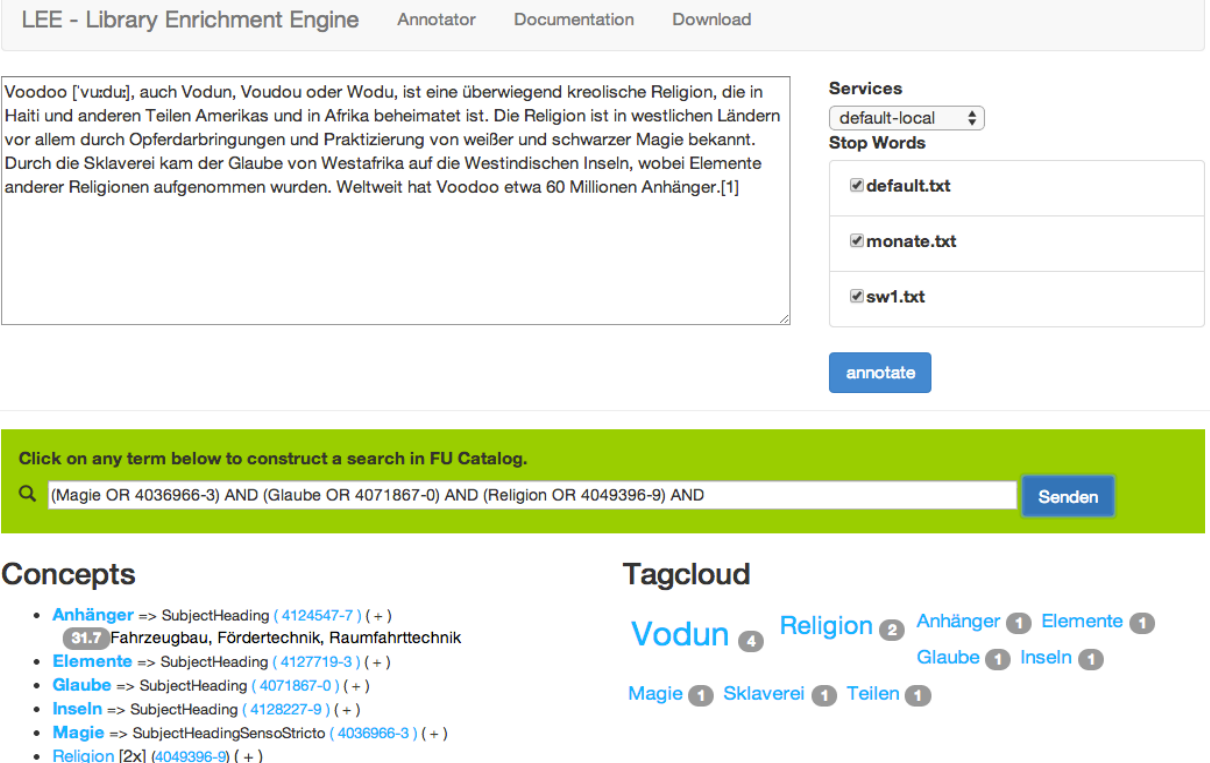
Figure 5. node.js application built on top of the Fusepool platform using its REST